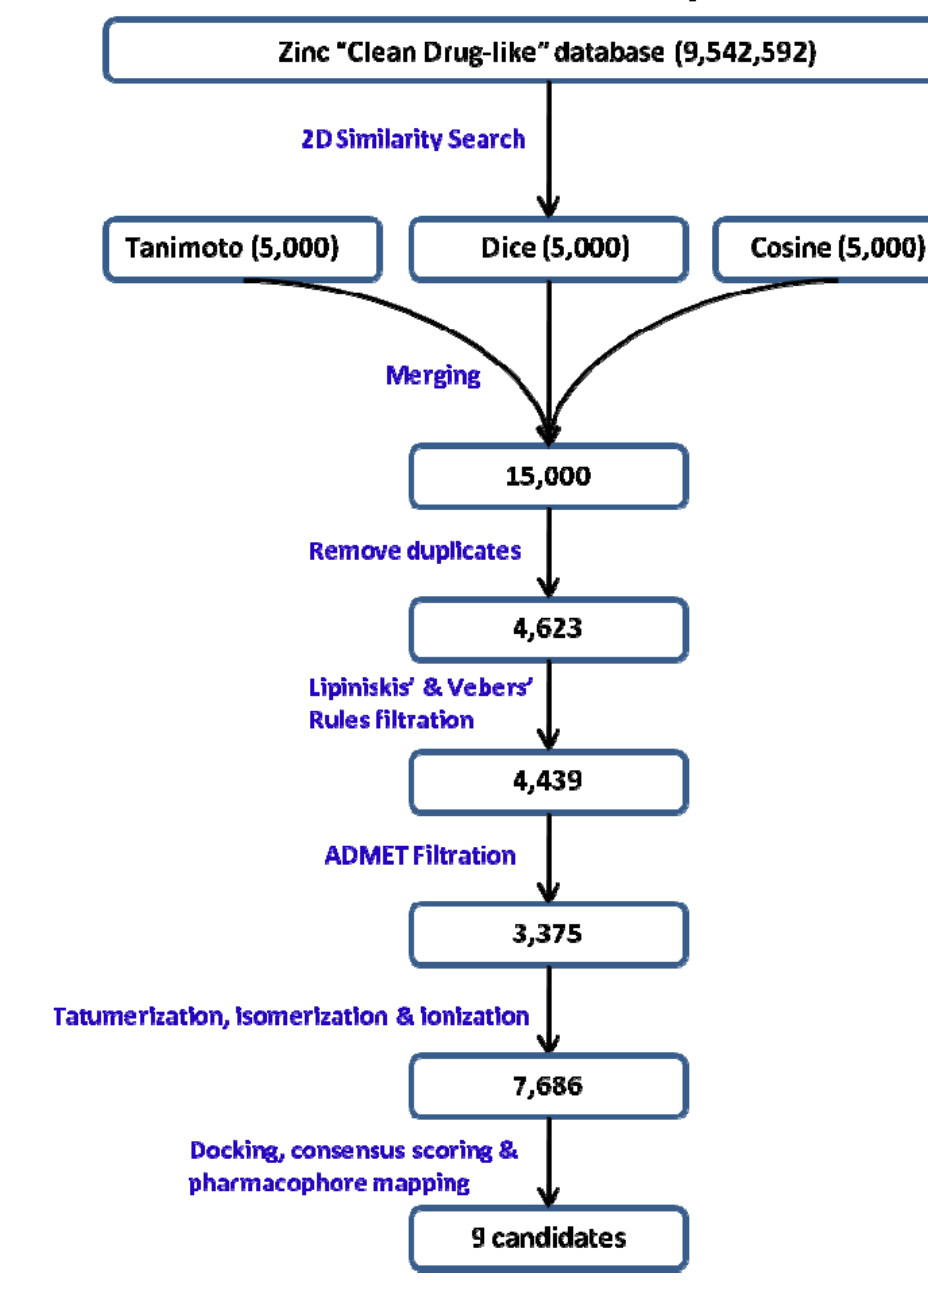
Figure 7. Steps in the drug discovery process to find potential inhibitors of Glo-1